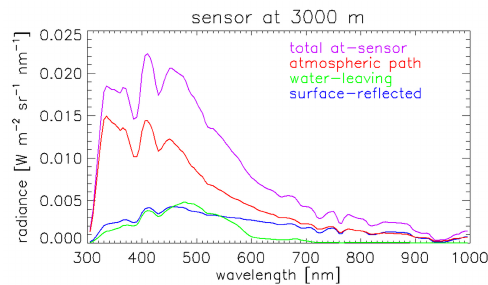
Figure 3. At-sensor radiance for a sensor at 3000 m, divided into the contributions from the atmospheric effects, surface effects and water-leaving radiance. Retrieving the water-leaving radiance is often the principle goal of ocean colour remote sensing, and as it is only a relatively small percentage of the total contribution, it is important to accurately estimate the other factors that deteriorate the signal. The data were created with a radiative transfer simulation [152]. Figure courtesy of C. Mobley, Ocean Optics Web Book